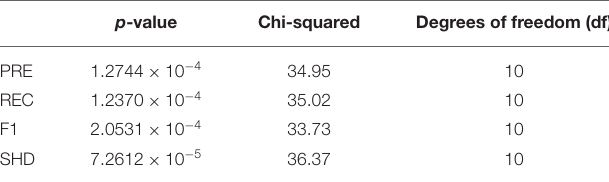
31.8, which is the smallest value among all 11 algorithms. TABLE 4 | The Friedman test results of 11 algorithms on four